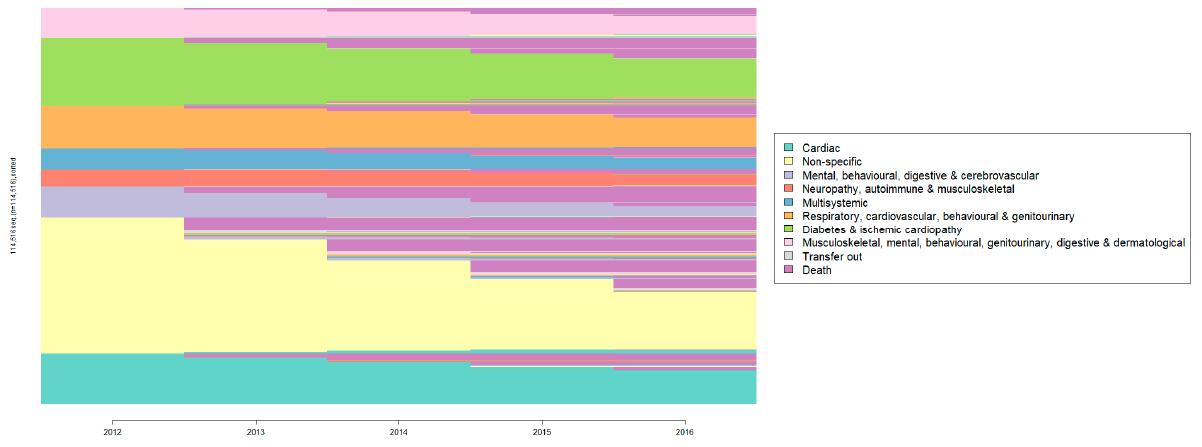
Figure 3. Patterns longitudinal sequences of individuals sorted by initial pattern.